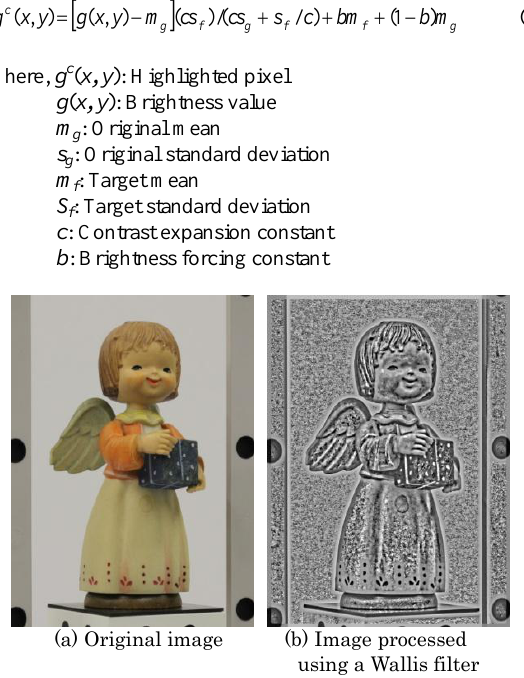
Figure 4. Image processed using a Wallis filter.